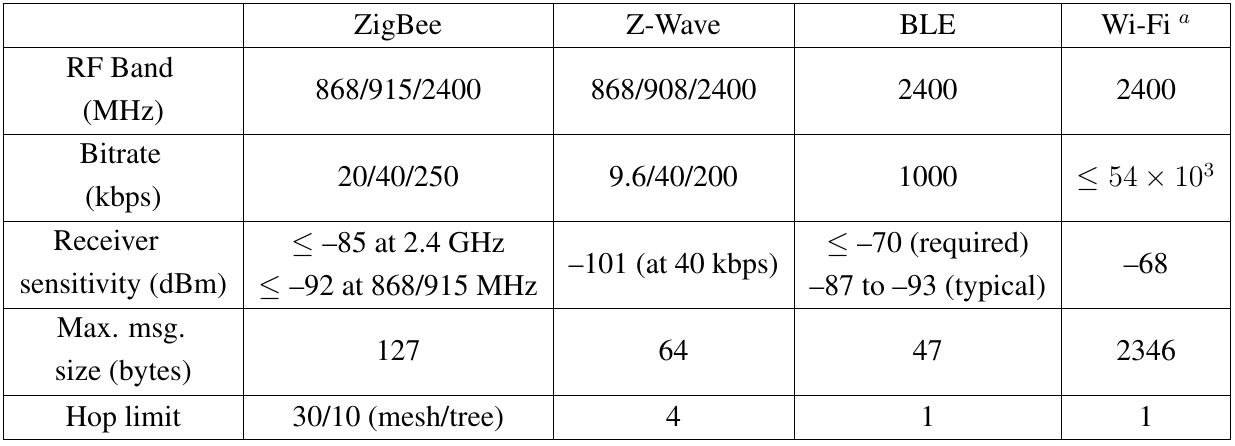
Table 1. Key performance feature comparison of different wireless home automation network (WHAN) technologies. BLE, Bluetooth Low